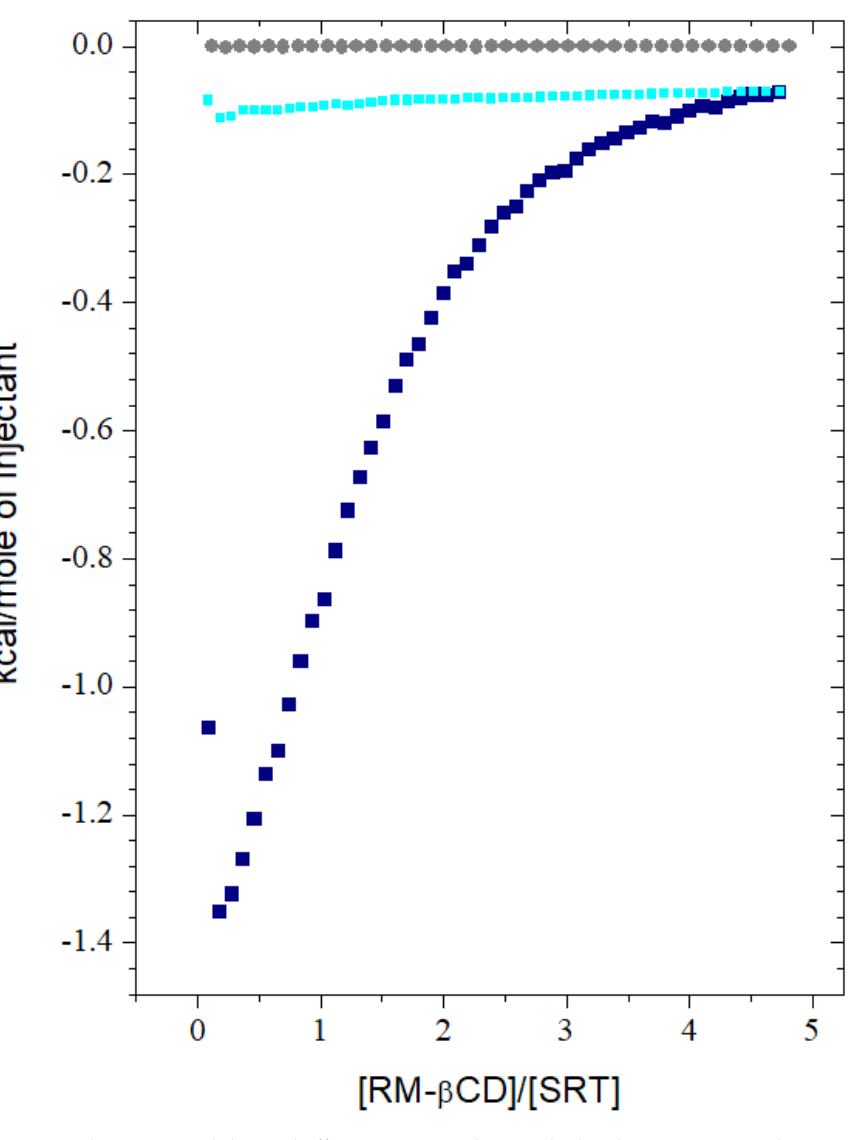
Figure 2. The integrated thermal effects corresponding to the binding interaction during titration of a 0.45 mM sertraline hydrochloride solution (in a cell) with a 15 mM solution of randomly methylated- β -cyclodextrin (in a syringe) ( ■ navy blue) for aqueous solutions with pH ≈ 6.8 at 298.15 K under atmospheric pressure p = 101,800 Pa together with the effects of SRT ( ● gray) and RM β CD ( ■ cyan) dilution by pure water.